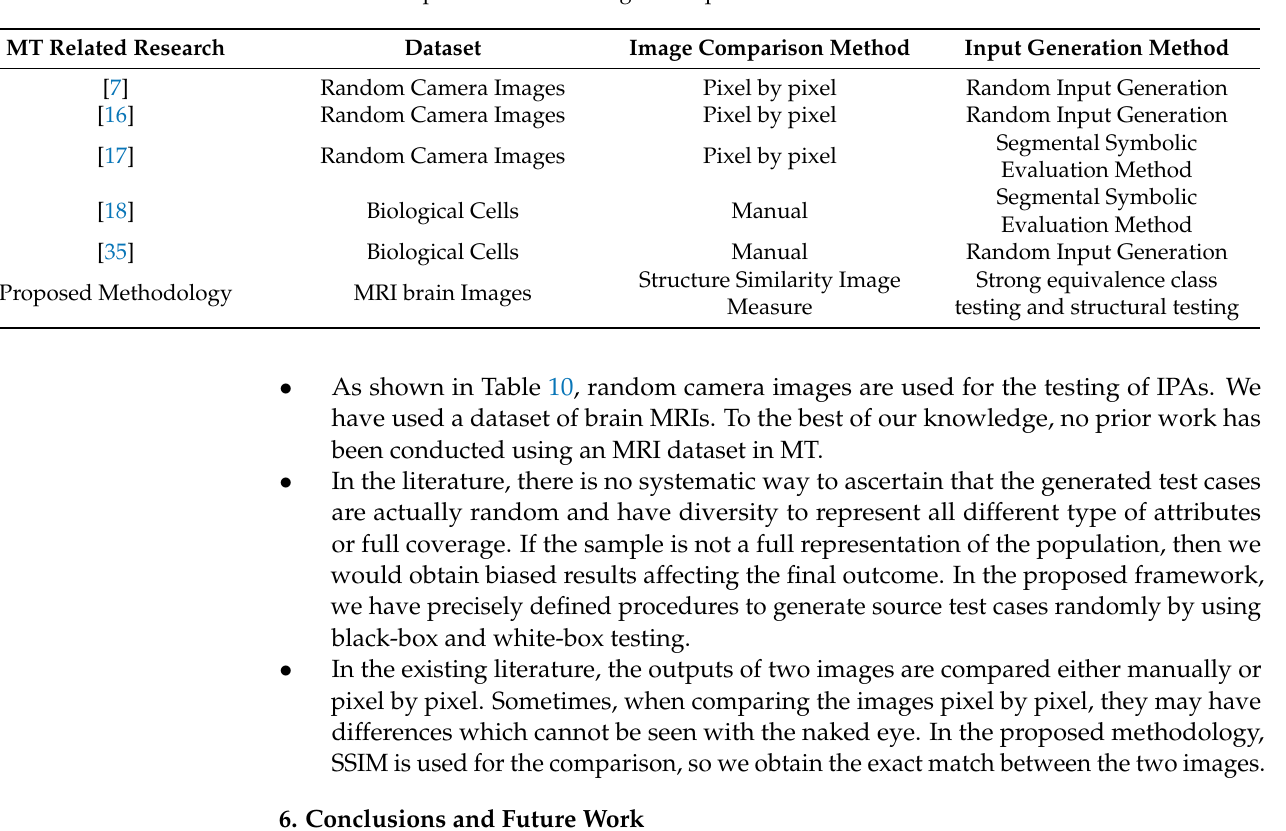
Table 10. Comparison with existing